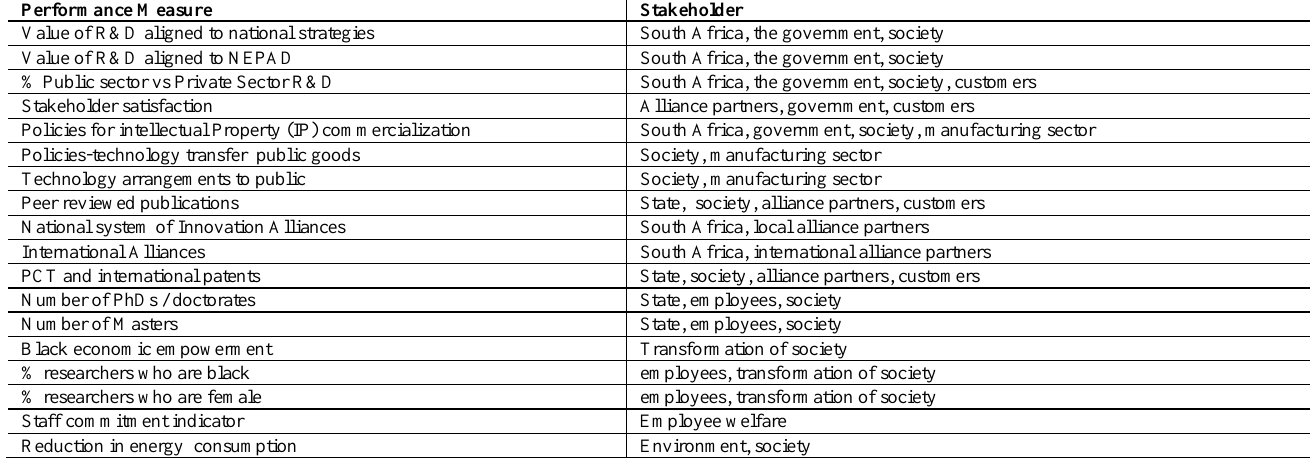
Table 4: Stakeholder based performance measures Performance Measure Stakeholder Value of R&D aligned to national